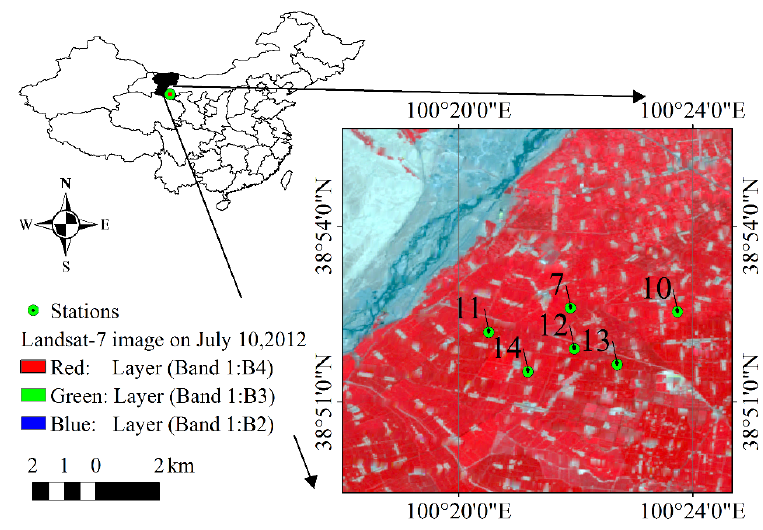
Figure 2. Spatial distribution of the testing sites.